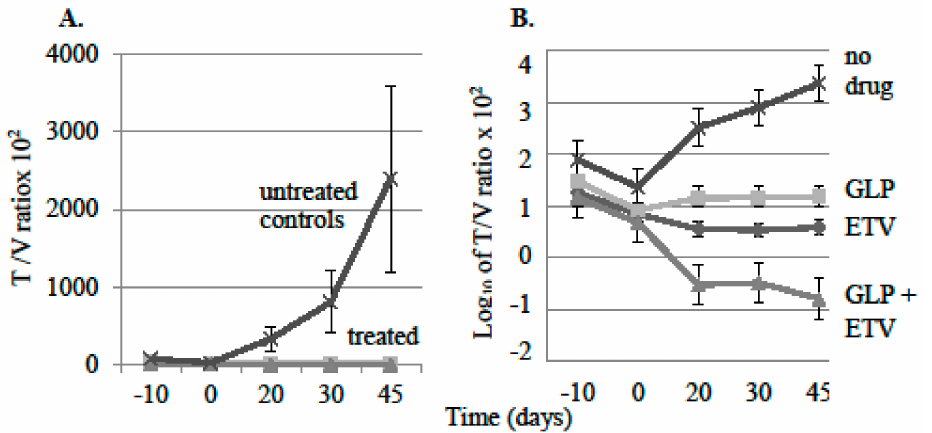
Figure 2. ( A ) Average HBV titer (DNA copies/mL serum per mm 3 tumor (T/V ratios) × 10 2 , of treated and untreated groups of mice. Error bars were calculated as standard error of the means (SE). ( B ) Data from panel A plotted logarithmically for each group of